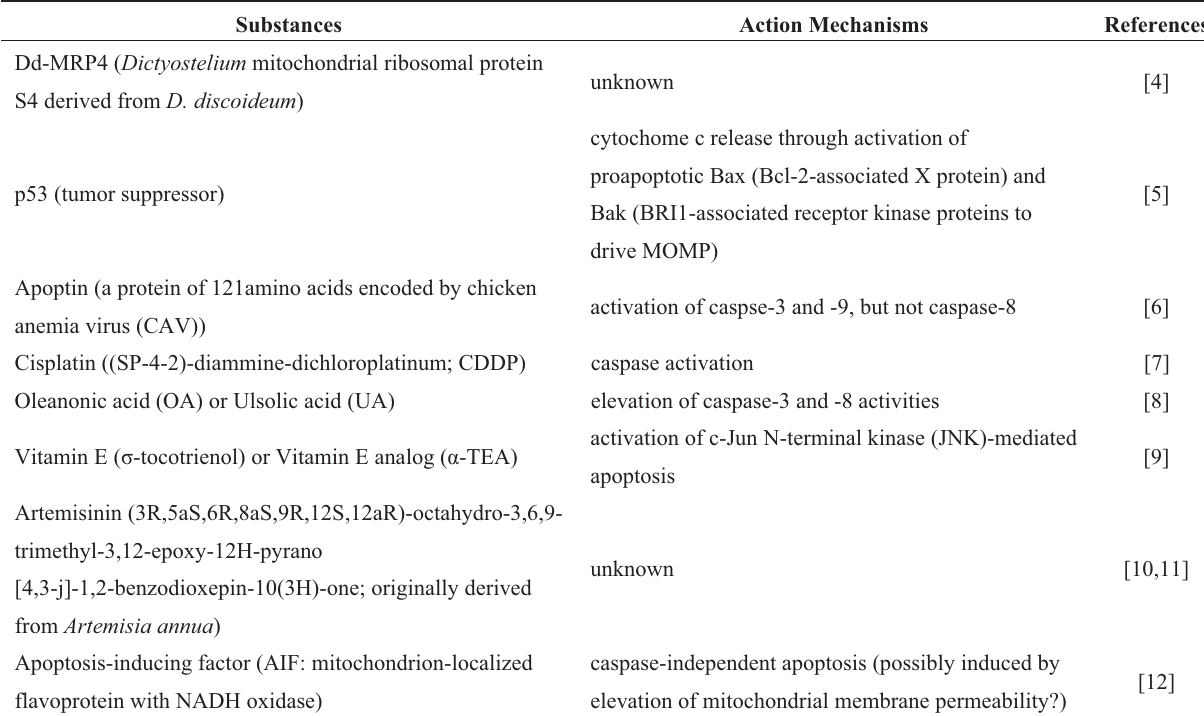
Table 1. Summary of main substances with apoptotic anti-cancer